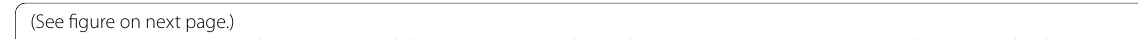
(See figure on next page.) Fig. 5 OsCBM1 interacts with OsRacGEF1 and their coexpression enhanced reactive oxygen species (ROS) production. A Split‑ubiquitin yeast two‑hybrid assays of the “bait” pGBKT7‑OsRacGEF1 with the “prey” pGADT7‑OsCBM1. B Firefly luciferase complementation imaging (LCI) assay. C MBP‑pull down assay, showing the interaction of OsCBM1 with OsRacGEF1 in vitro. D Co‑immunoprecipitation (Co‑IP) assay, showing the physical interaction of OsCBM1‑eGFP with OsRacGEF1‑6 cMyc in vivo. E Transient coexpression of OsCBM1 and OsRacGEF1 in the leaves of Nicotiana × benthamiana . The 3,3 ′ ‑diaminobenzidine (DAB)‑stained N. benthamiana leaves were transiently transformed with cMyc (P 35S ‑cMyc), OsCBM1 (P 35S ‑OsCBM1), OsRacGEF1 (P 35S ‑OsRacGEF1), and their combination, respectively. The DAB staining intensity in situ ROS levels of agroinfiltrated N. benthamiana leaves in each treatment was calculated based on the stain intensity of the control cMyc. Bars annotated with different letters represent values that are significantly different ( p 0.05) according to a one‑way ANOVA. F Detection of ROS production by H 2 DCFDA fluorescent ≤ probe in N. benthamiana protoplasts isolated from the leaves of N. benthamiana agroinfiltrated by different vectors. Bars 10 μm. The intensity of = fluorescent signals was calculated with ImageJ 1.8.0 software and presented with scatter diagrams (the bottom images in F